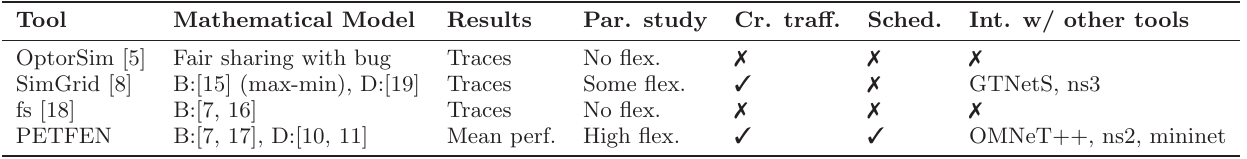
Table 1: Comparison of existing tool using flow-level network modeling. Abbreviations used: “perf.” = per- formances, “B:” = Base model, “D:” = Detailed model, “Par. study” = Parameter study, “flex.” = flexiblility, “Cr. traff” = Cross traffic modeling, “Sched.” = Packet scheduling modeling, “Int. w/” = Interaction with. of cross-traffic on TCP. Results of SimGrid for the evalua- tion of TCP flows were shown to be accurate in [19]. Like PETFEN, it also includes modules for interacting with ex- ternal tools (ns3 and